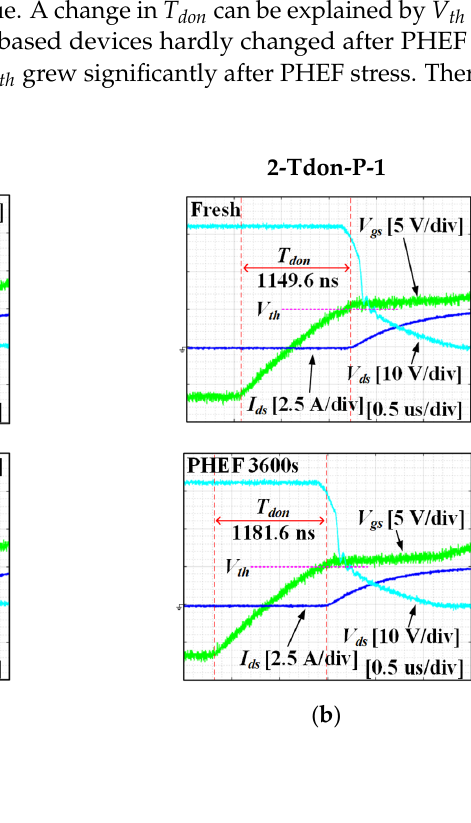
Figure 11. DPTC ( a ) circuit diagram, and ( b ) picture of DPTC.